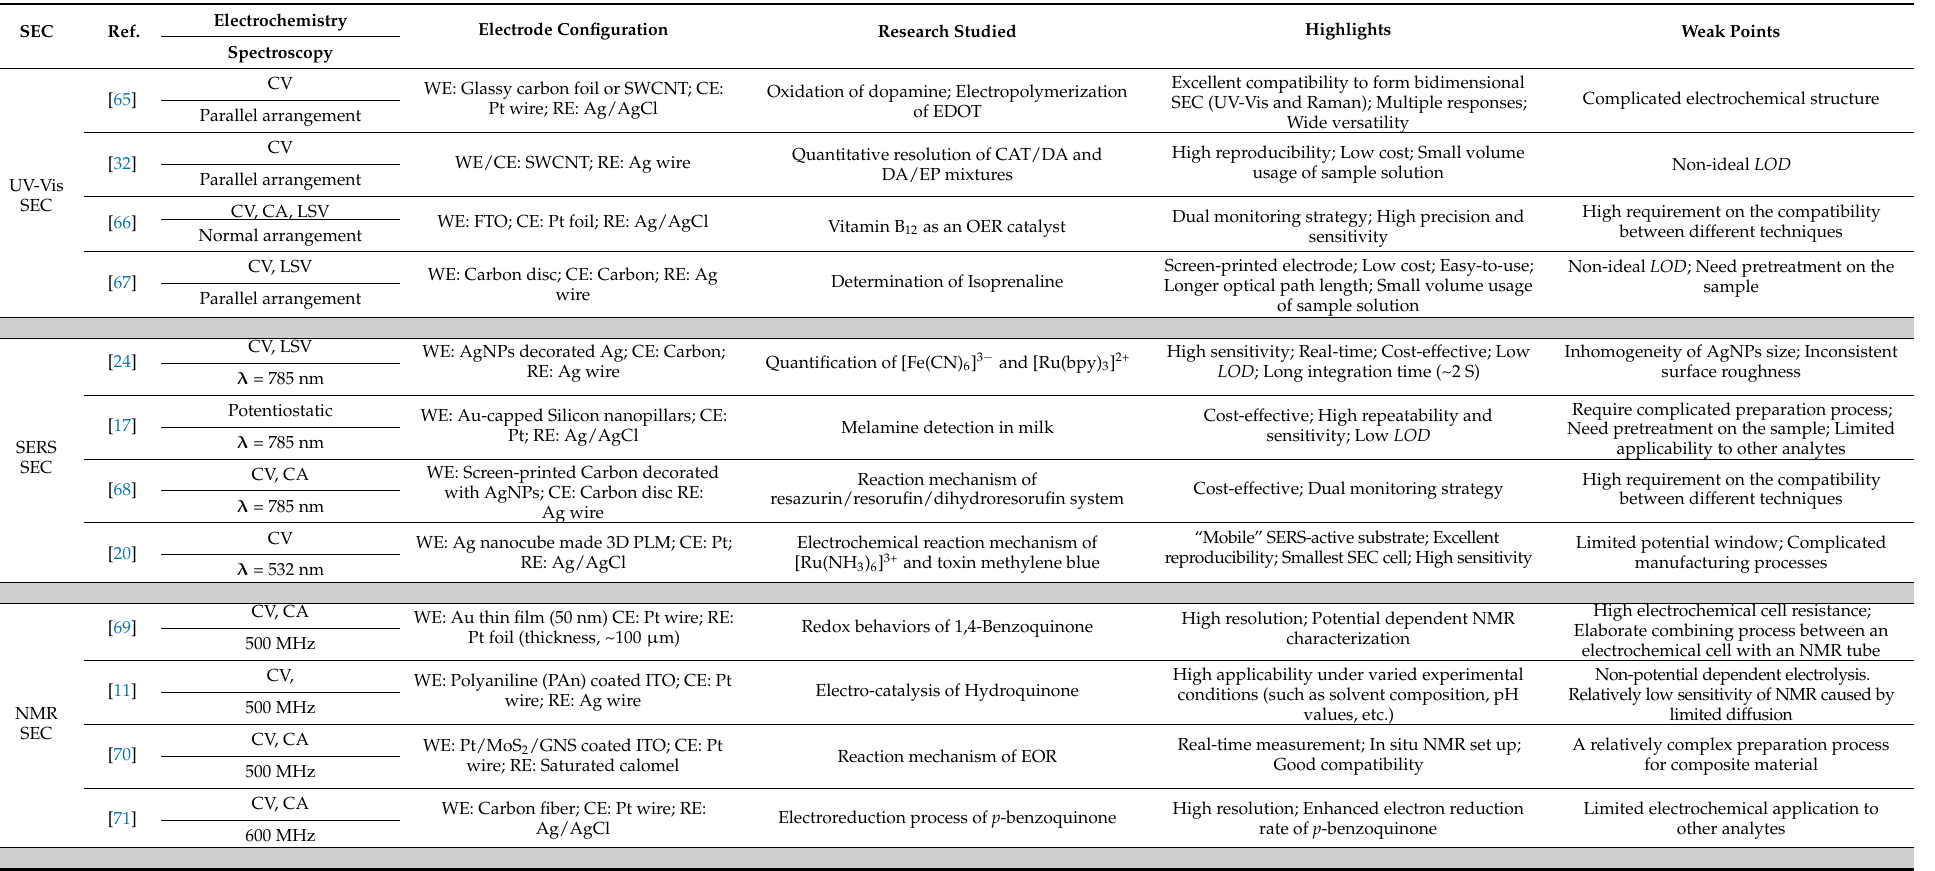
Table 2. Applications summary of UV-Vis SEC, SERS SEC, NMR SEC, and DFM SEC in different research